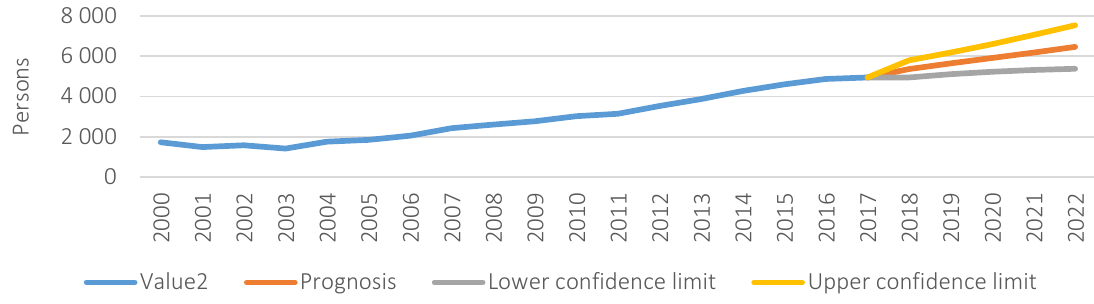
Figure 2. Prognosis of the development of the number of physicians in post-productive age in the SR until